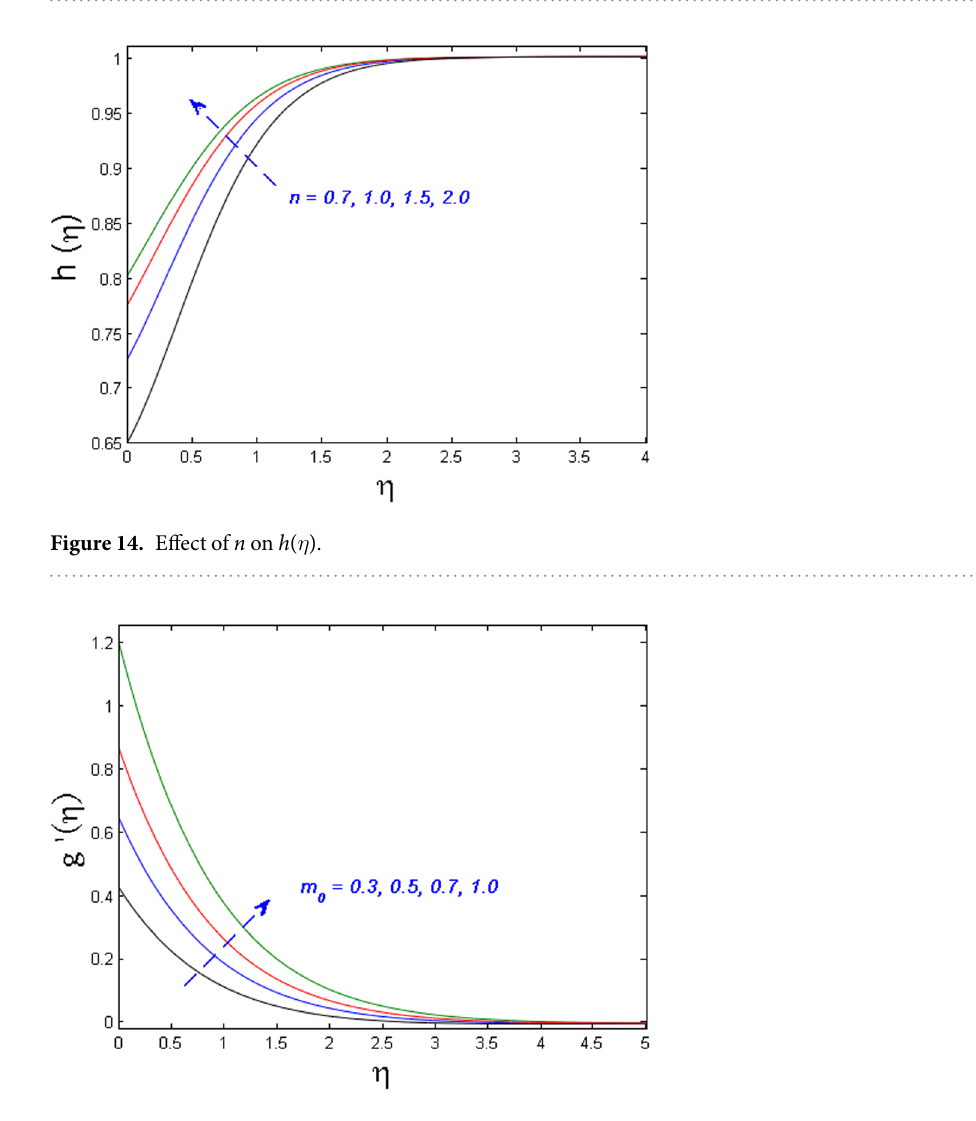
Figure 15. Effect of m 0 on g ′ ( η